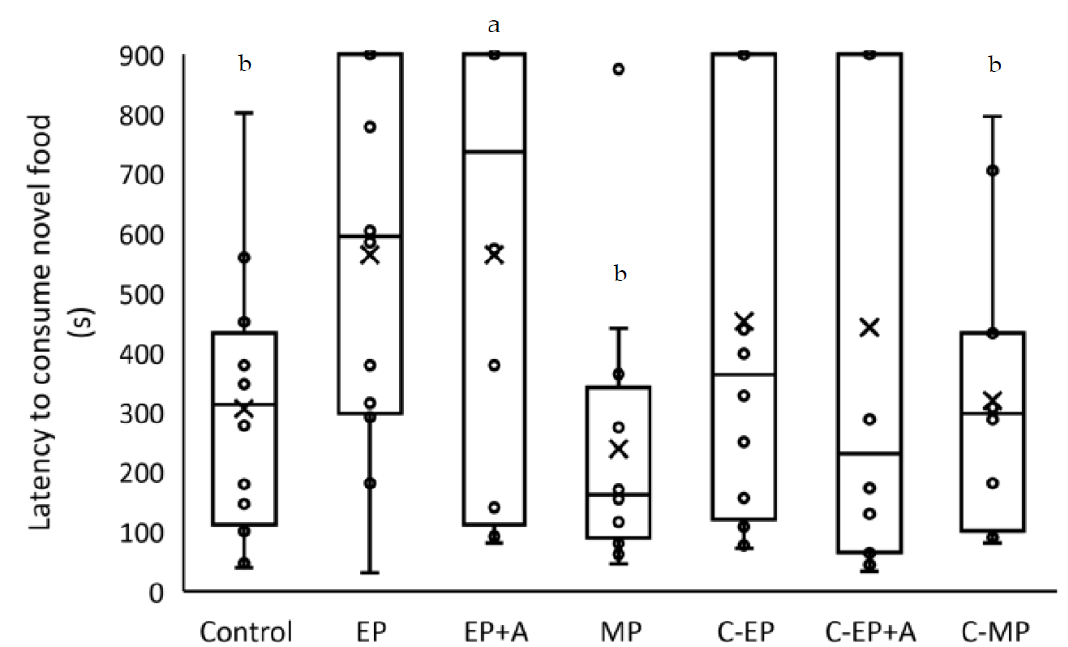
Figure 4. Effects of identification marking methods on latency to eat a novel food item. Data from all mice are displayed (box with bar = median +/ − IQR; x = mean), including those who did not consume novel sweetcorn and thus attained the maximum latency of 900 s ( n = 12/group). The treatments are as follows: Control = neither mouse was marked; EP = ear-punch; EP+A = ear-punch plus anaesthetic cream; MP = permanent marker on the tail; C-EP = cagemates of EP mice; C-EP+A = cagemates of EP+A mice; C-MP = cagemates of MP mice. a Significantly fewer mice consumed novel food than b ( p = 0.001), but the latencies of mice who did consume food showed no significant treatment effects.